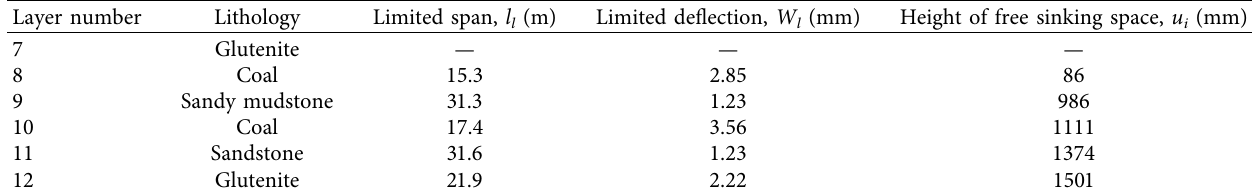
Table 6: The calculation of water flowing fractured zone height H